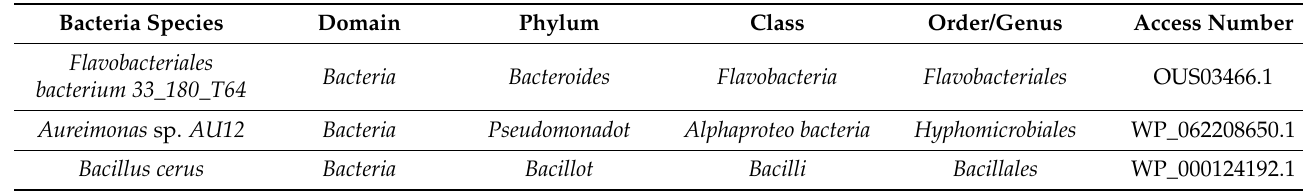
Table 5. Proteins for which emPAI was significantly higher in the control group compared to the study